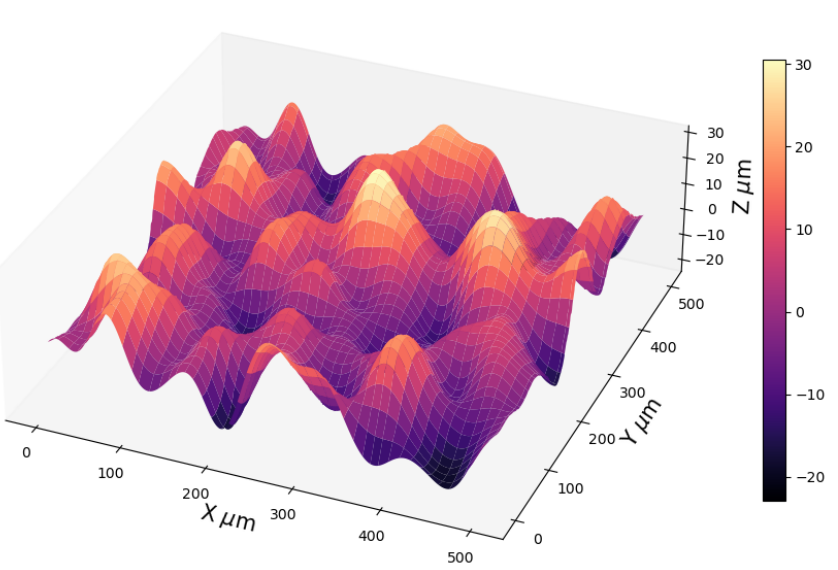
Figure 1. Three-dimensional random surface with RMS height of 5 µ m, τ x = 40 µ m, and τ y = 50 µ